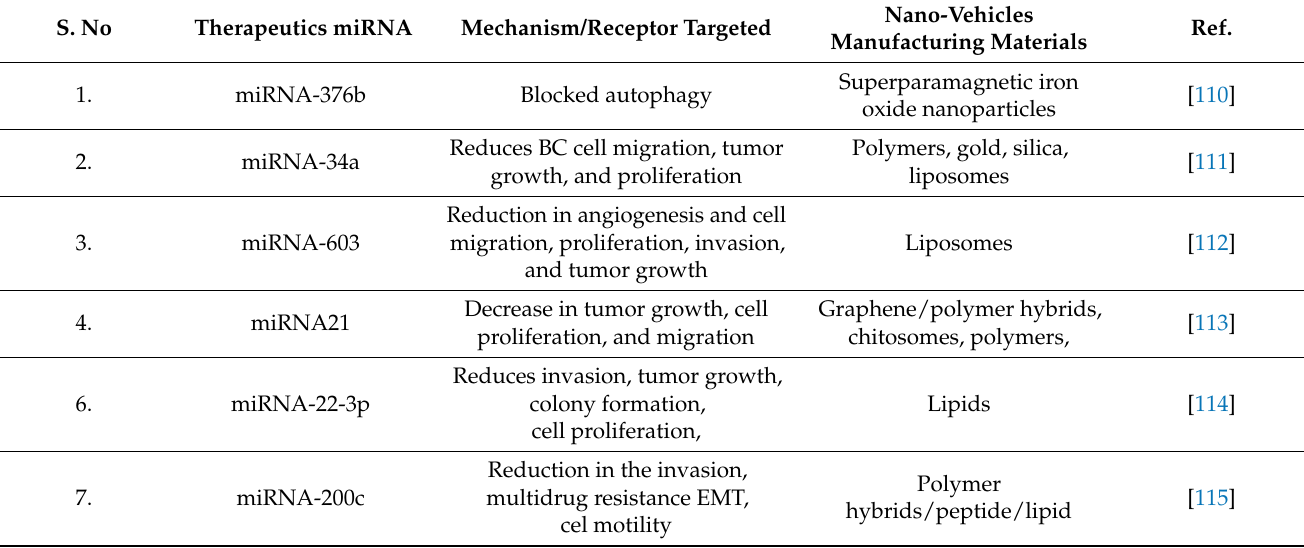
Table 2. The potential therapeutic delivery of TS miRNAs in BC and associated